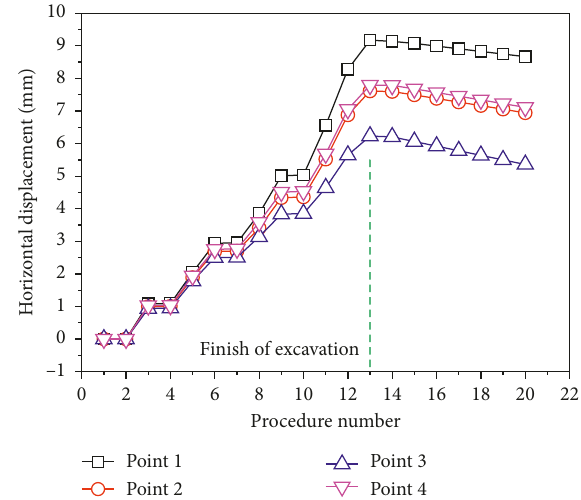
Figure 12: Horizontal displacement of the tunnel structure without isolation pile